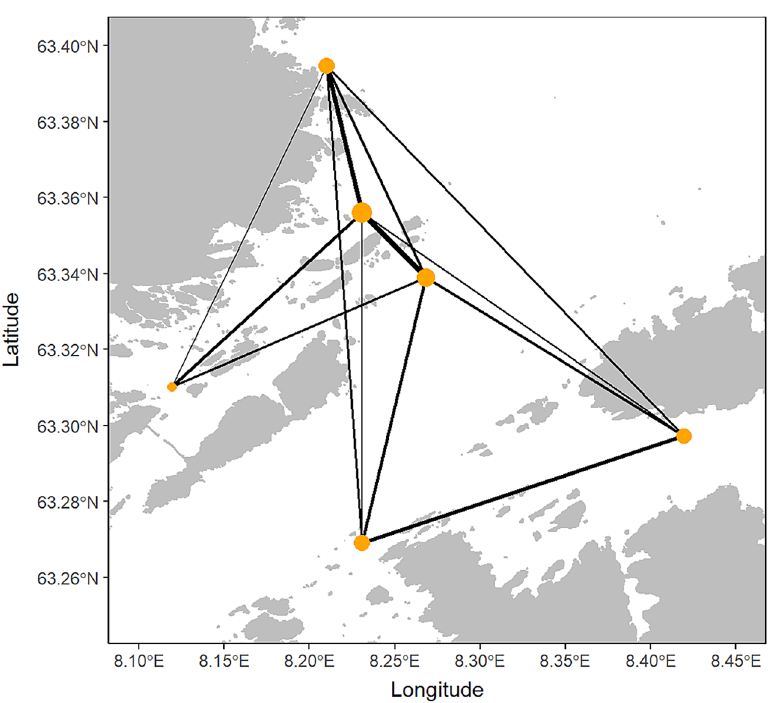
Fig. 8. Salmon farm network. Node size is scaled to number of cod detected; line widths connecting different farms are scaled to the log of the number of fish that used that